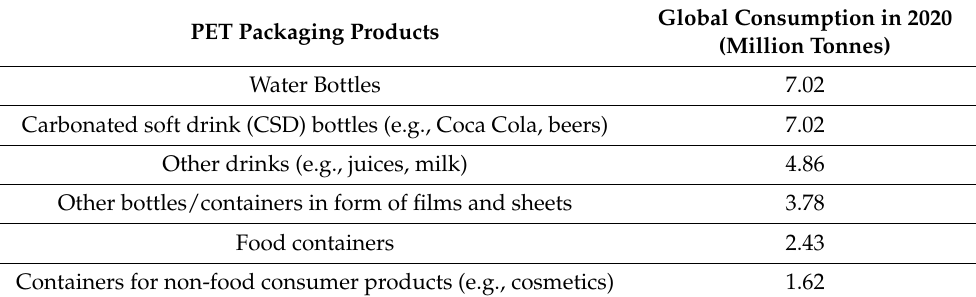
Table 1. Polyethylene terephthalate (PET) packaging products based on end-user consumption.